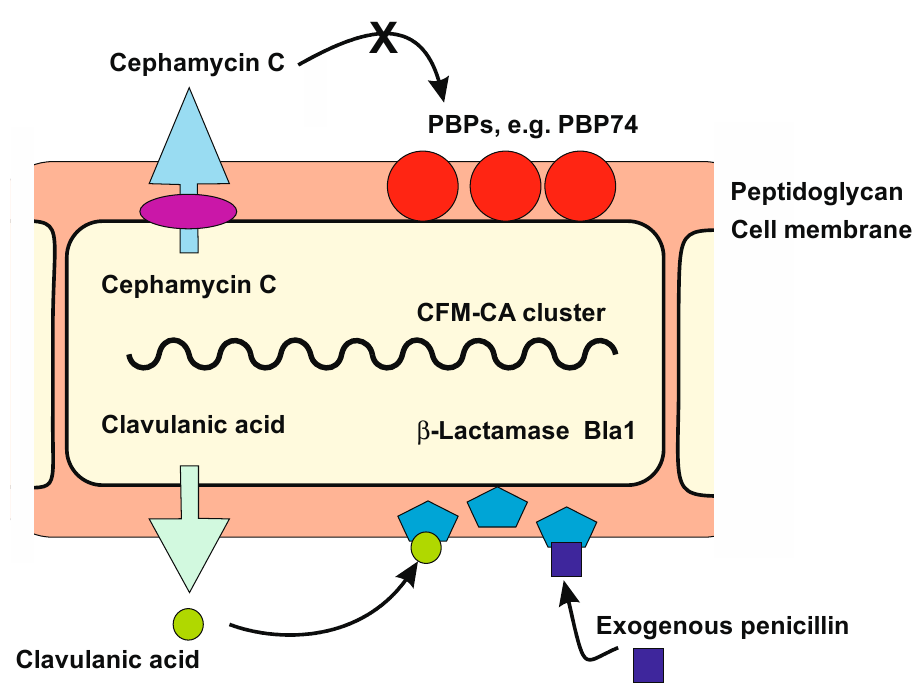
Figure 1. Proposed model of the major resistance mechanisms to β -lactam antibiotics in β -lactam- producing S. clavuligerus. A S. clavuligerus cell (part of the mycelium) is shown in yellow color; the cell wall peptidoglycan is indicated in pink. PBPs (e.g., PBP74) are located in the cell wall (red circles). Cephamycin C encoded by the CFM-CA cluster is secreted through an efflux pump (purple ellipse). The secreted cephamycin C does not bind to the insensitive PBPs of S. clavuligerus (indicated by an X symbol) . The β -lactamase Bla1 is secreted and retained in the cell wall matrix (blue pentagons). Clavulanic acid encoded by the CFM-CA cluster is also secreted (green circle), although the nature of the efflux mechanism is uncertain. The Bla1 β -lactamase inactivates the exogenous penicillin produced by filamentous fungi living in the same habitat (dark blue squares). The secreted clavulanic acid binds the Bla1 β -lactamase, modulating its activity. A similar mechanism occurs in other β -lactam-producing actinobacteria (see text for details).